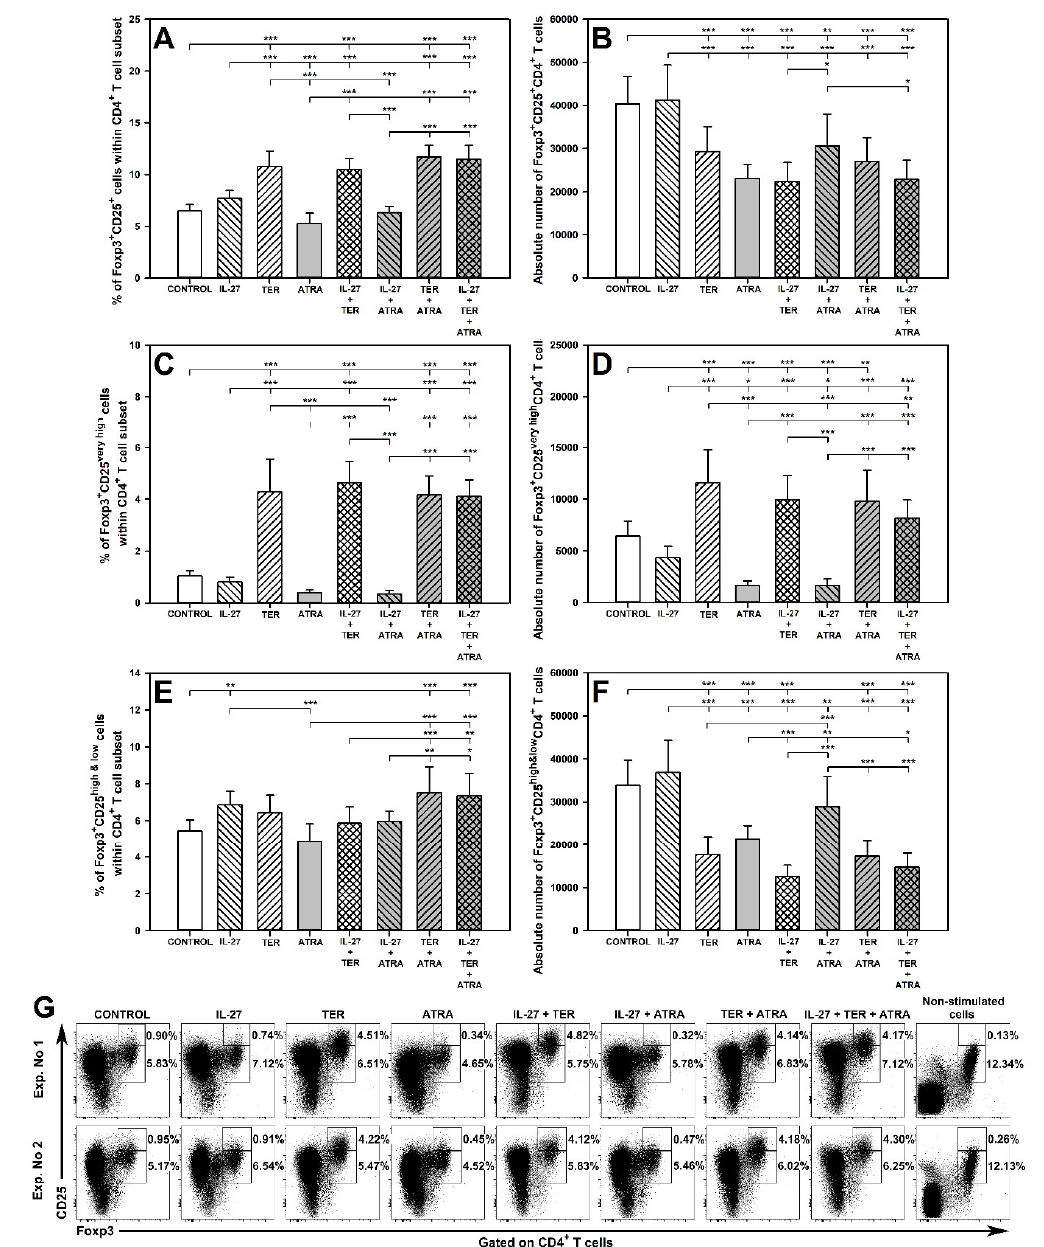
Figure 3. Effect of IL-27, teriflunomide (TER), all-trans-retinoic acid (ATRA), and their combinations on the number of Foxp3-expressing regulatory T (Treg) cells—taking into account their total popu- lation and subsets with very high and high + low CD25 expression—under activation conditions. The relative ( A , C , E ) and absolute count ( B , D , F ) of particular cell subsets were determined in cell cultures incubated in the absence (CONTROL) and presence of IL-27 (100 ng/mL), TER (10 −4 M), and ATRA (10 −6 M) for 72 h including concomitant stimulation with IL-2, anti-CD3, and anti-CD28 and re-stimulation with PMA and ionomycin for the last 5 h before harvest. The relative count is expressed as a percentage of Foxp3 + CD25 + ( A ), Foxp3 + CD25 very high ( C ), and Foxp3 + CD25 high&low ( E ) cells within CD4 + T cell subset. The absolute count represents the number of Foxp3 + CD25 + CD4 + ( B ), Foxp3 + CD25 very high CD4 + ( D ), and Foxp3 + CD25 high&low CD4 + ( F ) T cells per sample well. Results are expressed as the mean ( ± S.D.) of three independent experiments with four mice per experiment (overall n = 12, * p < 0.05, ** p < 0.01, *** p < 0.001). Examples of dot plot cytograms for all treatments show the distribution of Foxp3 + CD25 + cells within CD4 + T cell subset ( G